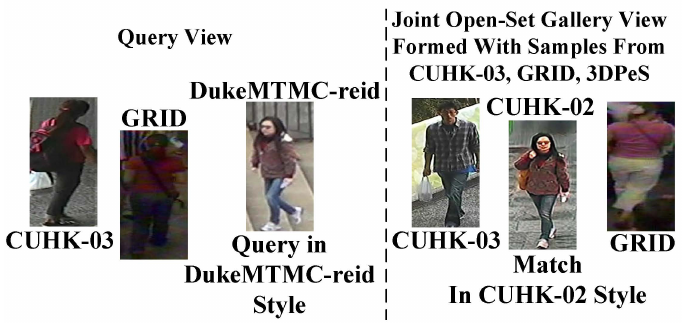
Figure 16. In the Challenging Open-World Scenario, the Query image can be seen in different domains, styles, or modalities, while the match is needed to be found from any other random domain, e.g., the CUHK-02 domain, while the matching image has a style or modality different from that of the Query image.